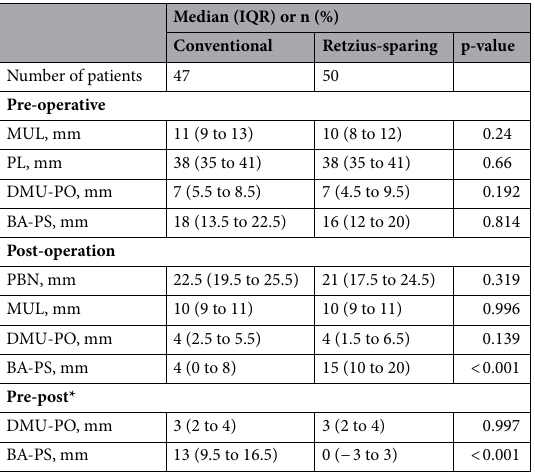
Table 2. MRI results of each robot-assisted radical prostatectomy. BA-PS, bladder attachment to public symphysis; DMU-PO, distal end of membranous urethra to misline of the pelvic outlet; PAL, public symphysis to prostate apex length; PBN, public symphysis to bladder neck; PL, prostate length. *Change from pre- to post.